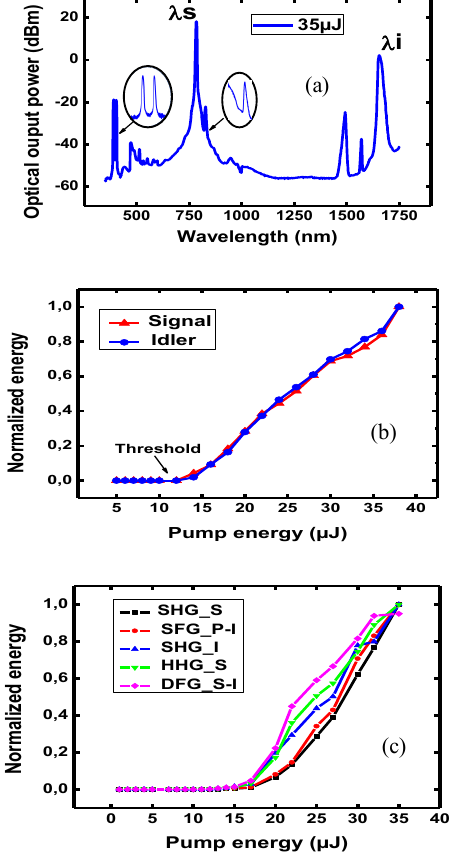
Fig.1. (a) The generated multi-wavelengths spectrum. (b) Threshold measurements of signal an idler and (c) of cascaded nonlinear processes. From 1D-PPLT nonlinear photonic crystal at